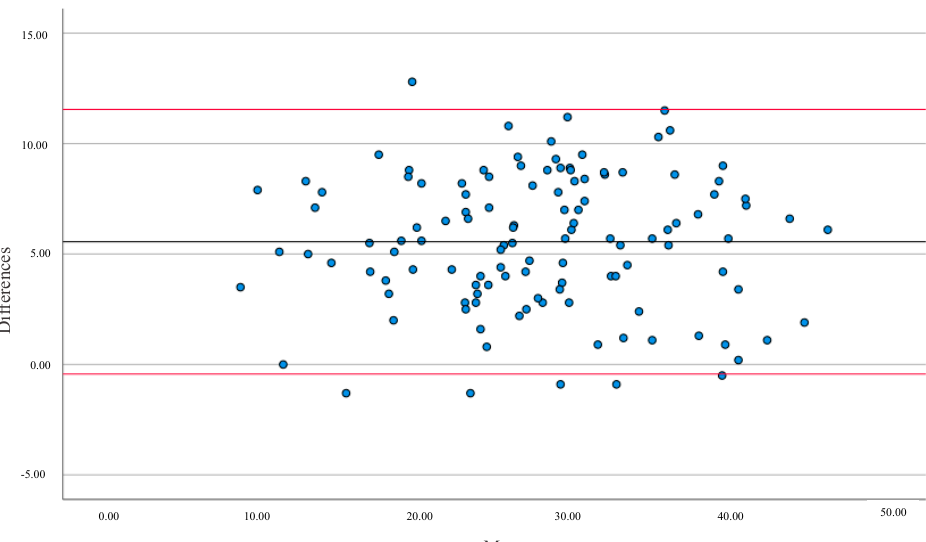
Figure 2. Bland-Altman analysis evaluated the differences in Percentage Body Fat (%BF) between the two equipment (BIA and DXA) versus the Averages between the values. The solid line represents the Mean (5.56) and the red lines represent ± 1.96 SD for all populations. Upper limit = 11.55 SD; lower limit = − 0.43 SD. Table 4 verified the percentage of misclassification bias (overestimation or underestimation of BIA relative to DXA) using a contingency table. The between-methods analysis classified 66.10% of the individuals in the same quintile concerning %BF and 70.30% concerning FFM. Table 4. Contingency tables for the percentage of misclassification between the quintiles of the two equipment (BIA and DXA) regarding body fat and fat-free mass.